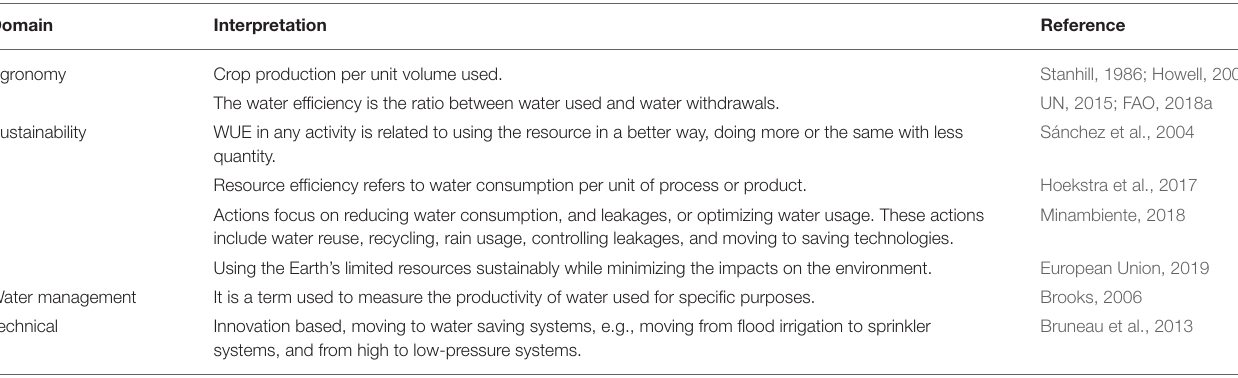
TABLE 1 | Diverse interpretations of WUE.